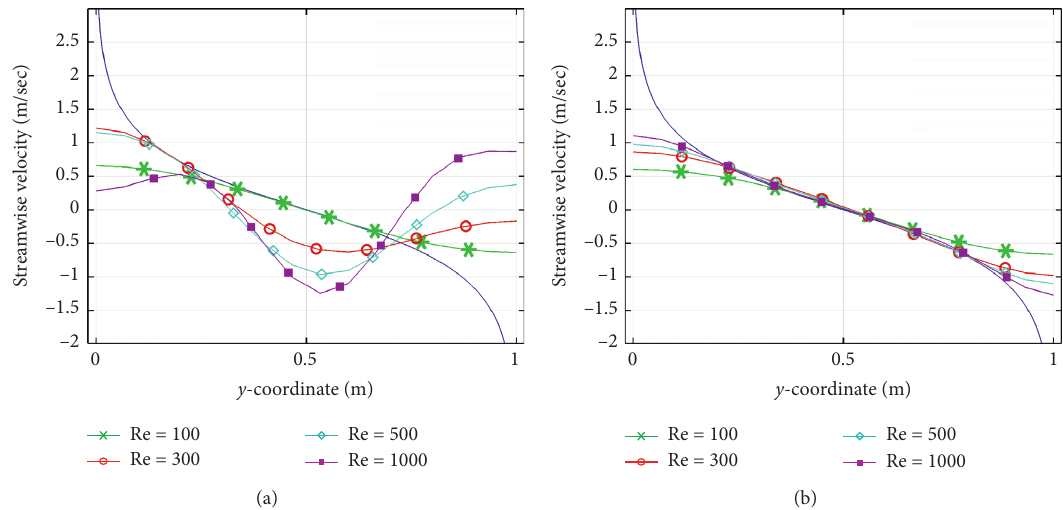
Figure 3: Comparison with the velocity at the stream. (a) With semicylinder and screen condition. (b) Without semicircular cylinder and screen condition.